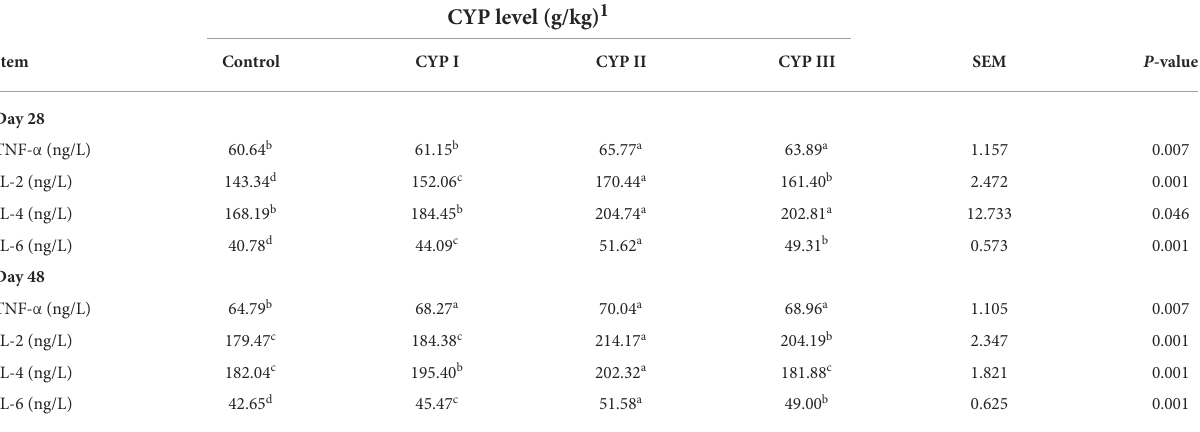
TABLE 5 Effects of CYP on the serum levels of cytokine TNF-a and IL-2, IL-4 and IL-6 levels in